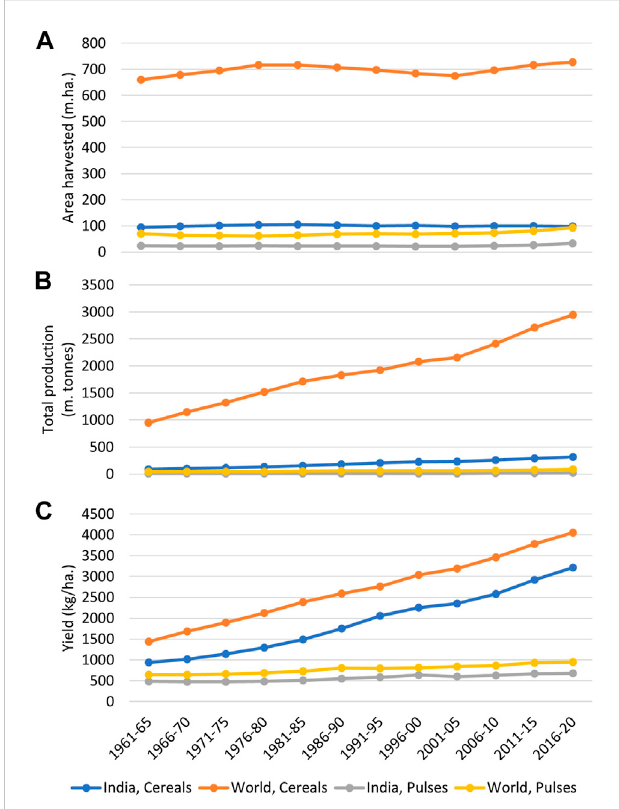
FIGURE 1 A graphical comparison of cereals and pulses in terms of total area harvested (A) , total production (B) , and yield (C) in India and the world. The graph indicates how the onset of the green revolution has tremendously enhanced the production of cereals in India and worldwide, which can be primarily attributed to yield improvement in these crops. By comparison, yield and production improvements in pulses have remained insigni fi cant during this period (Data source: FAOSTAT,